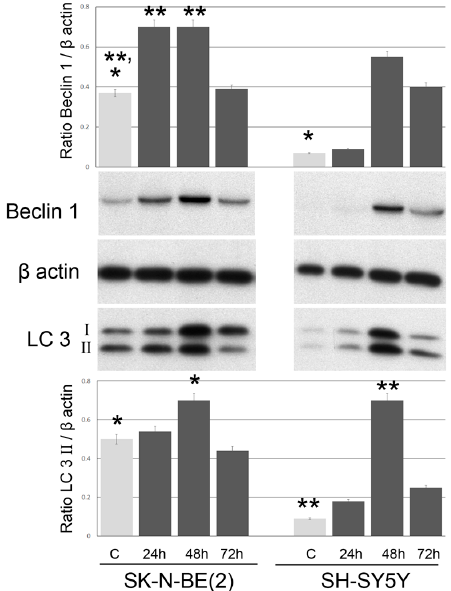
Figure 6. Expression levels of beclin 1 and LC3 in SK-N-BE(2) cells and SH-SY5Y. Representative experiment of three different Western blots of Beclin 1 (52 kDa), LC3 I (18 KDa) and LC3 II (16 KDa) in SK-N-BE(2) cells and SH-SY5Y at different times of incubation with GO. Proteins were detected by Western blot in whole cell lysates. Densitometry was performed on bands and results are expressed as ratio protein/ β actin. Histograms represent the mean values of three independent experiments ± SD. * and ** p < 0.05 for each exposure time compared to unexposed control (CTRL).